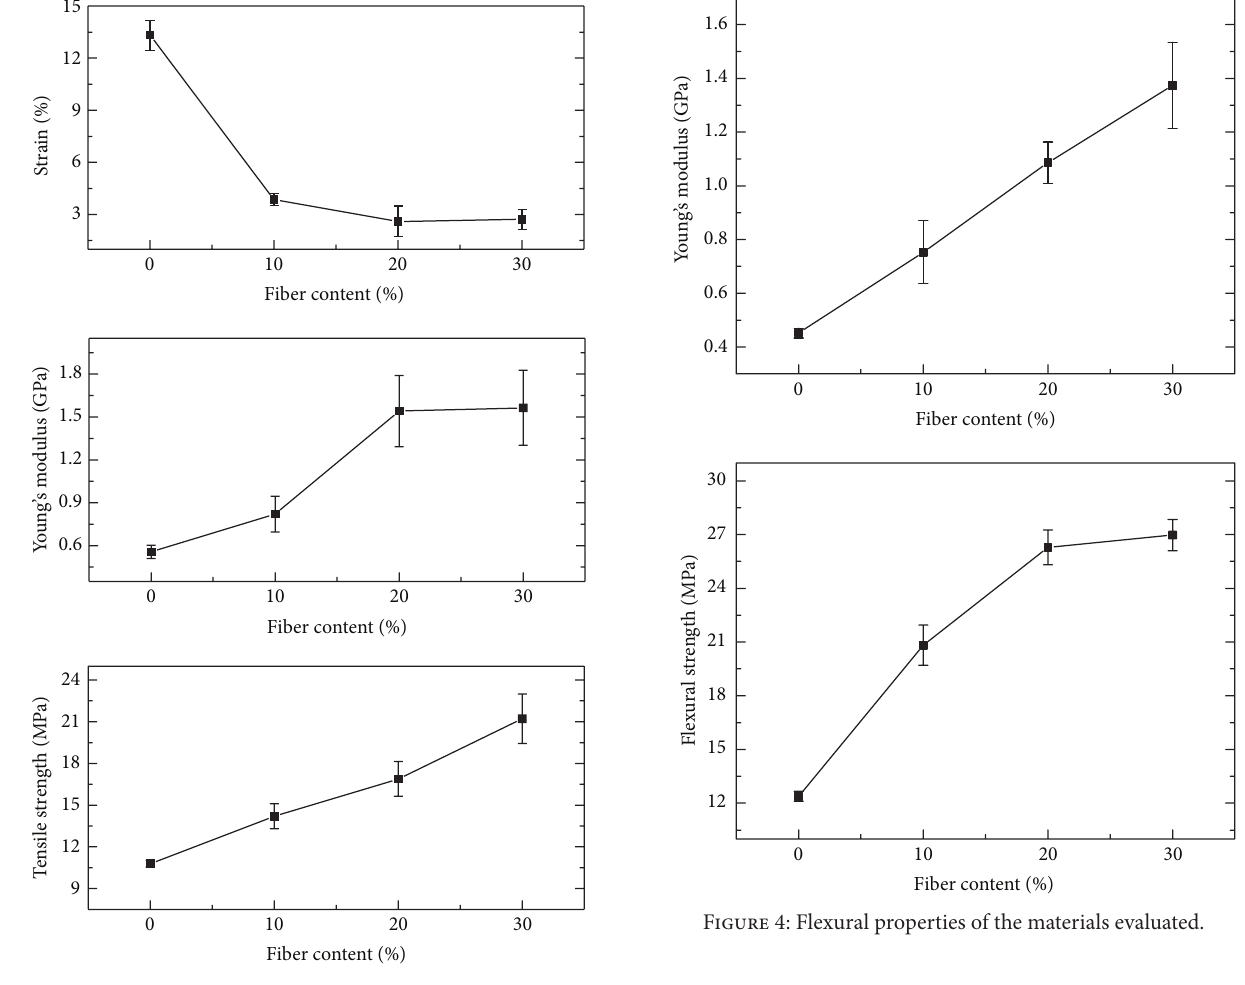
Figure 3: Tensile properties of the materials tested.